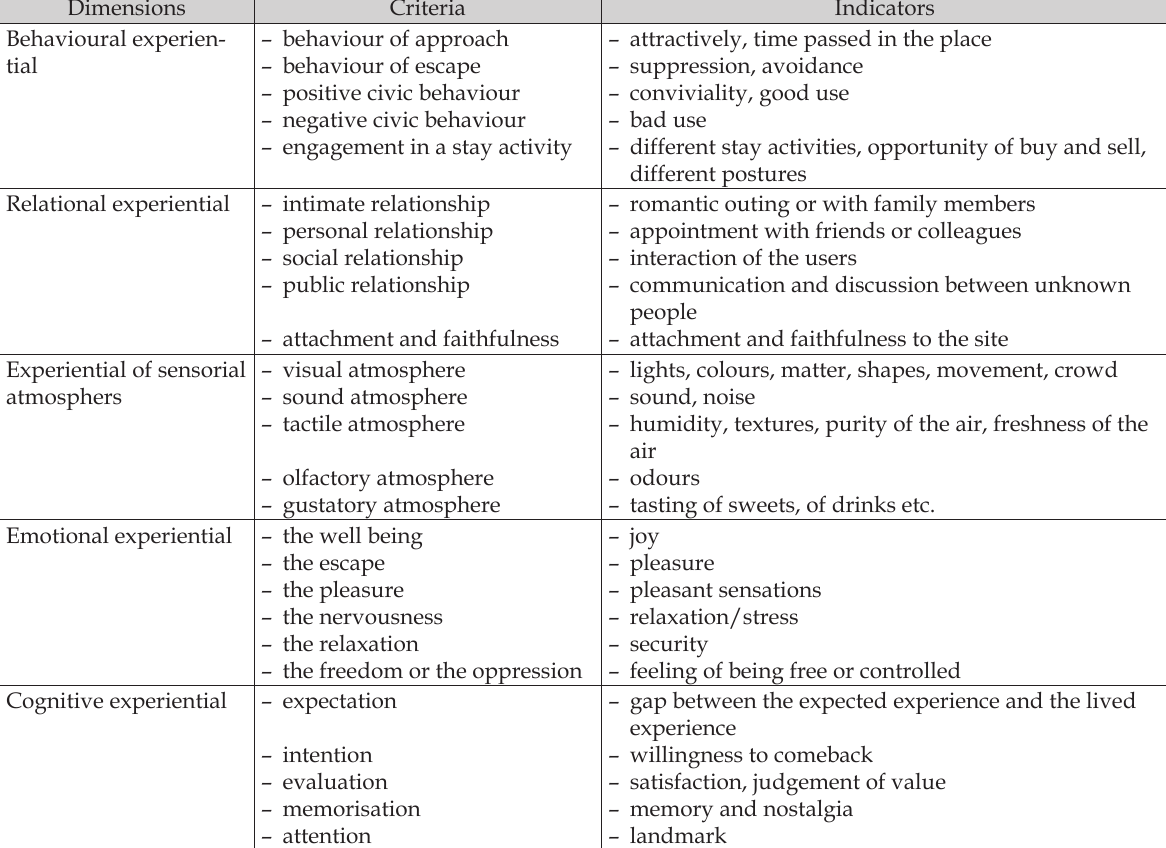
Table 2. Criteria and indicators constituting the experiential dimensions.